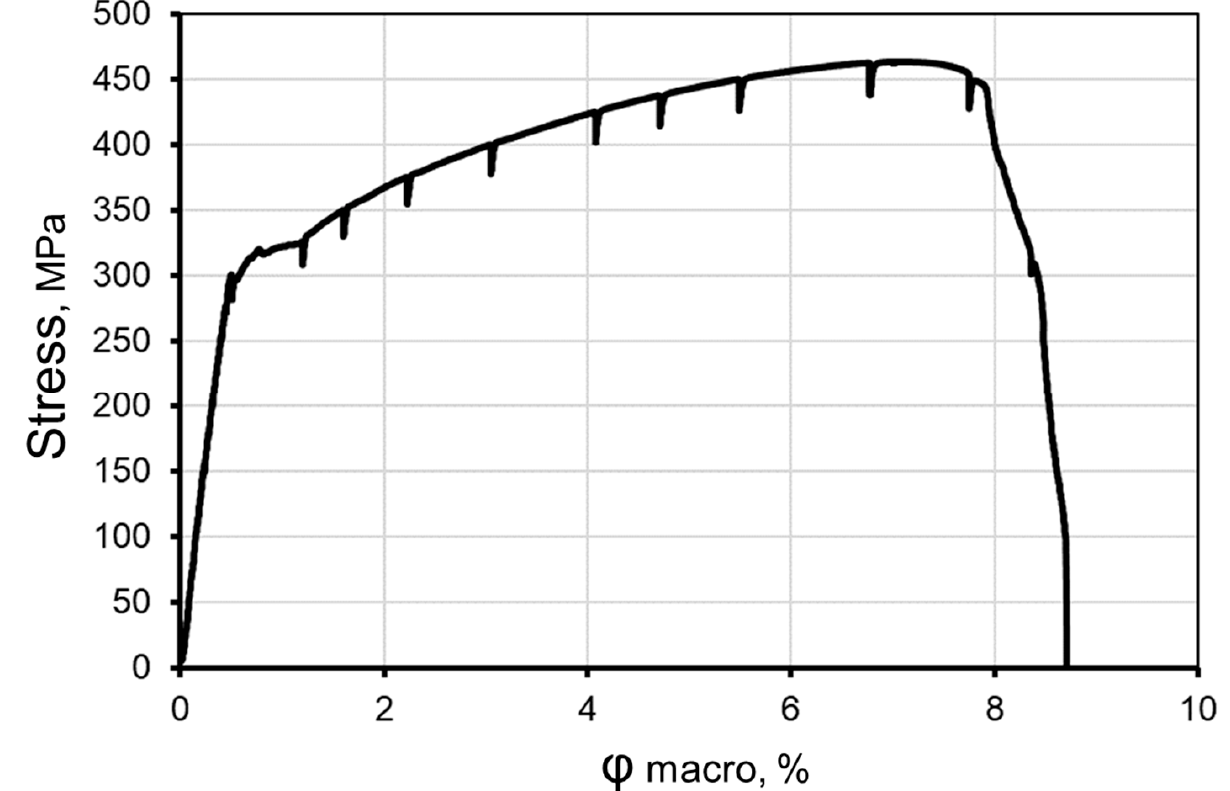
Figure A7. Stress–strain diagram of the tensile specimen. Based on the data obtained, diagrams were created to compare the meso deforma- tion and micro deformation in different areas of the study with the names of the se- lected areas (Figure A8). A diagram has also been created to compare macro and micro deformation (Figure